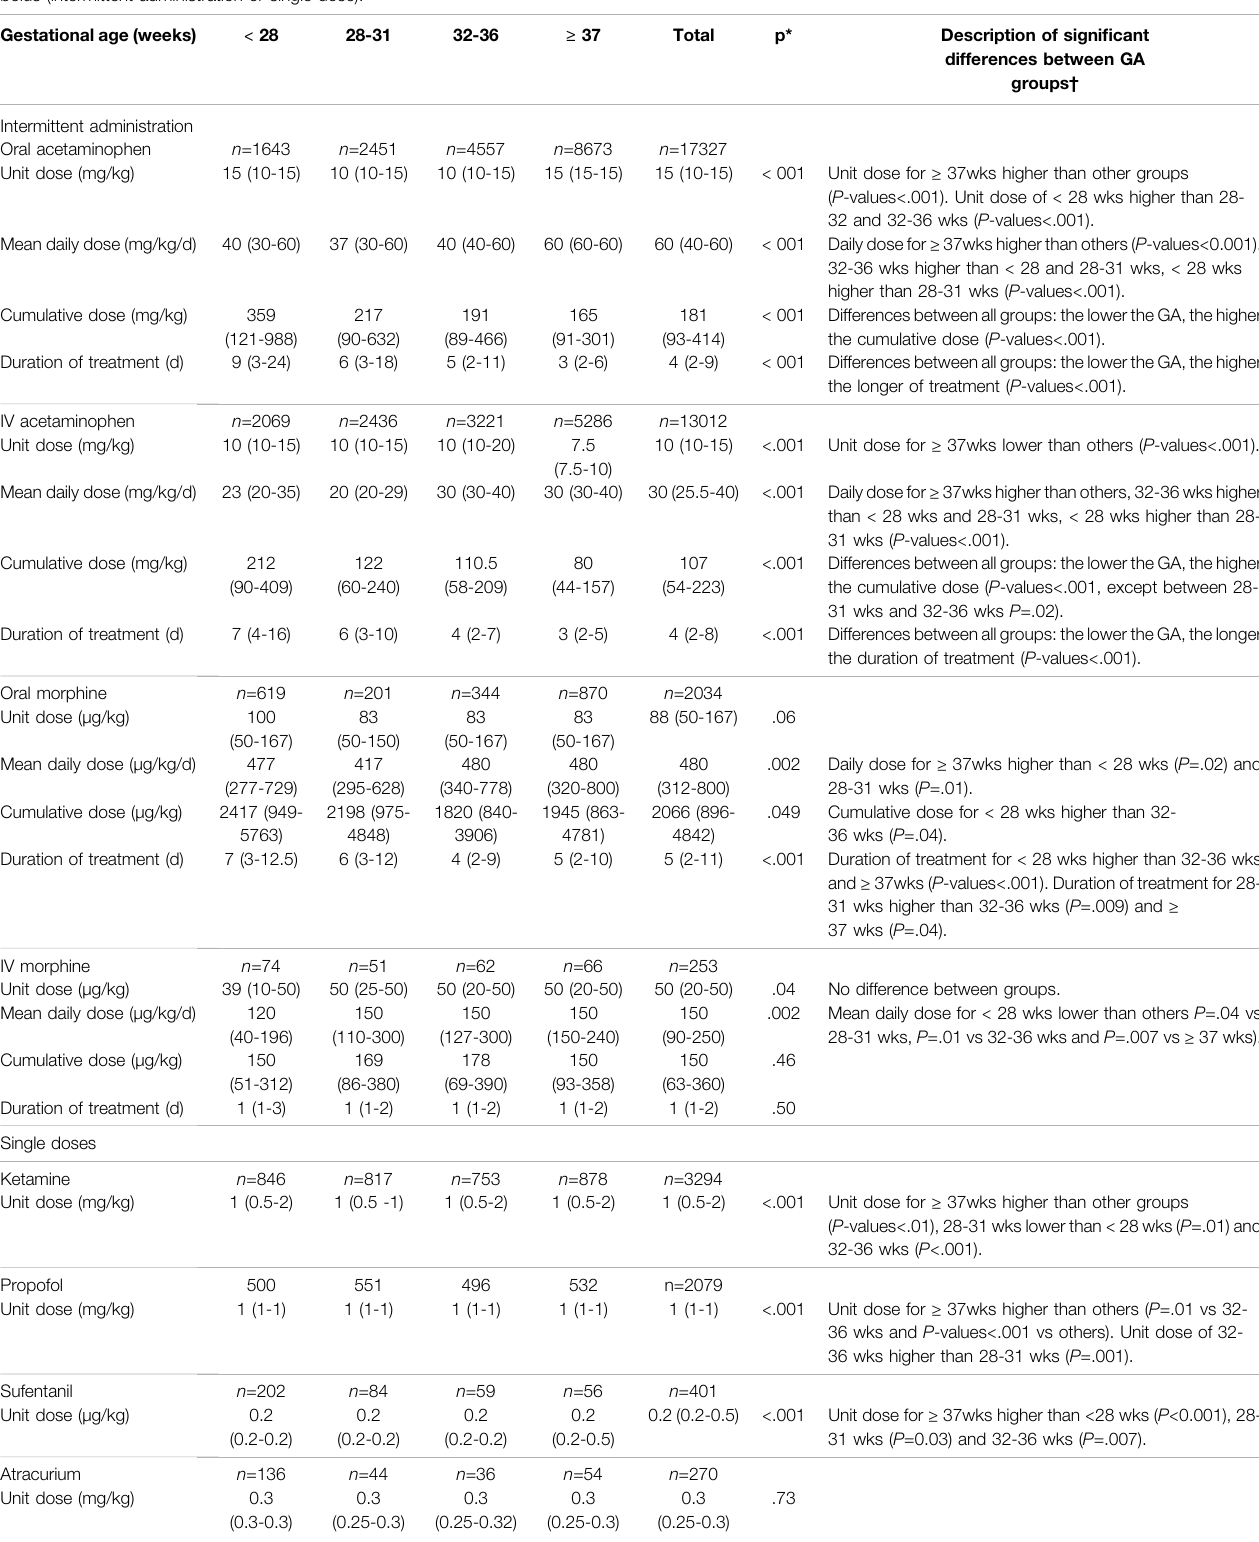
differences between GA groups †